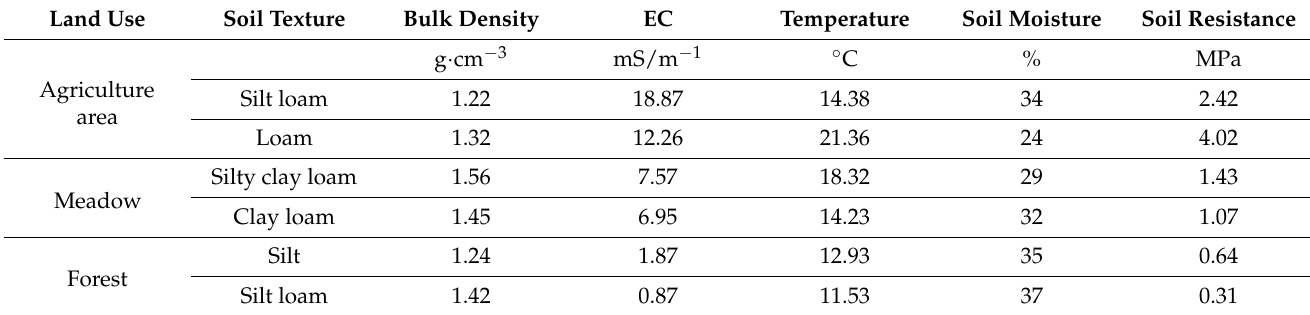
Table 1. Average values of selected parameters in the soil at the layer 0–20 cm for the Smugawka catchment. Land Use